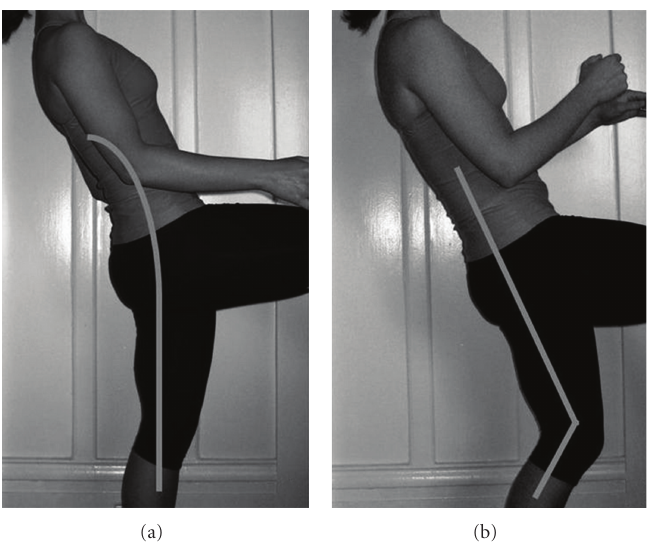
Figure 1: The stork test involves asking the patient to stand on one leg and to extend the low back. Pain indicates possible spondylolysis on the ipsilateral side. When properly done (a), the leg is straight and trunk tilt results from lumbosacral extension. Note that concurrent ipsilateral knee flexion (b) may produce trunk tilt without low back extension and subsequently produce lower test sensitivity.